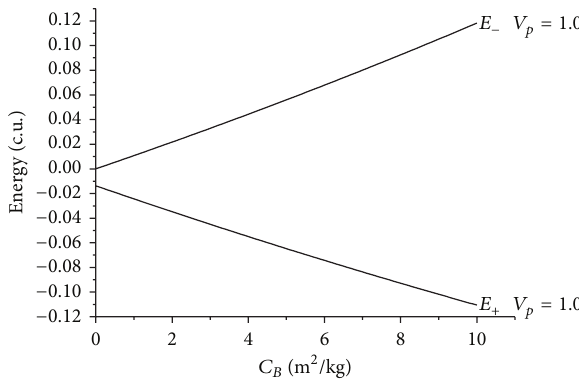
Figure 6: Evolution of the energies as a function of the ballistic coefficients for near-parabolic orbits for 𝜓 = 90 ∘ .